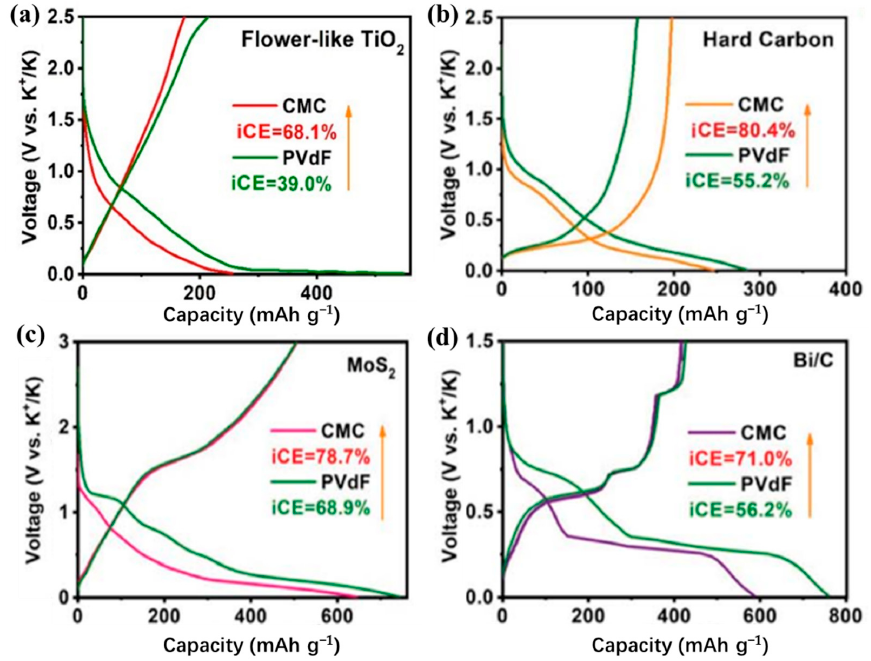
Figure 12. Advantages of CMC over PVdF as the binder in different electrode materials. ( a ) Flower- like TiO 2 , ( b ) hard carbon, ( c ) MoS 2 , and ( d ) Bi/C as the anode materials for K storage at 0.1 A/g. ( a – d ) Reproduced with permission from Ref. [158]. Copyright 2022 The Royal Society of Chemistry.